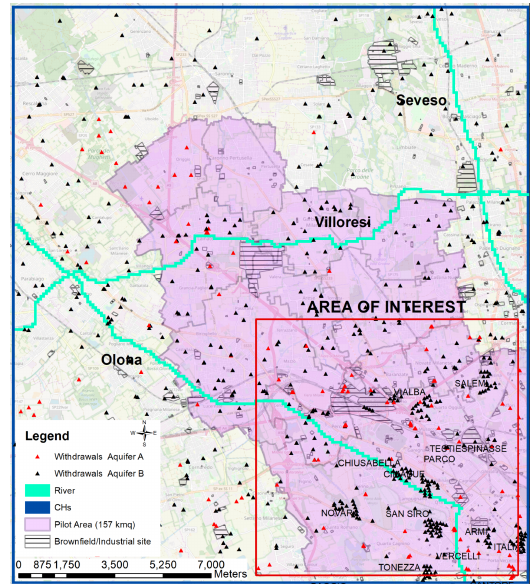
Figure 3. Boundary Conditions and Internal Conditions: Constant head (blue), rivers and canal (light-blue), and withdrawals differentiated by exploited Aquifer. The transport model is developed within the area of